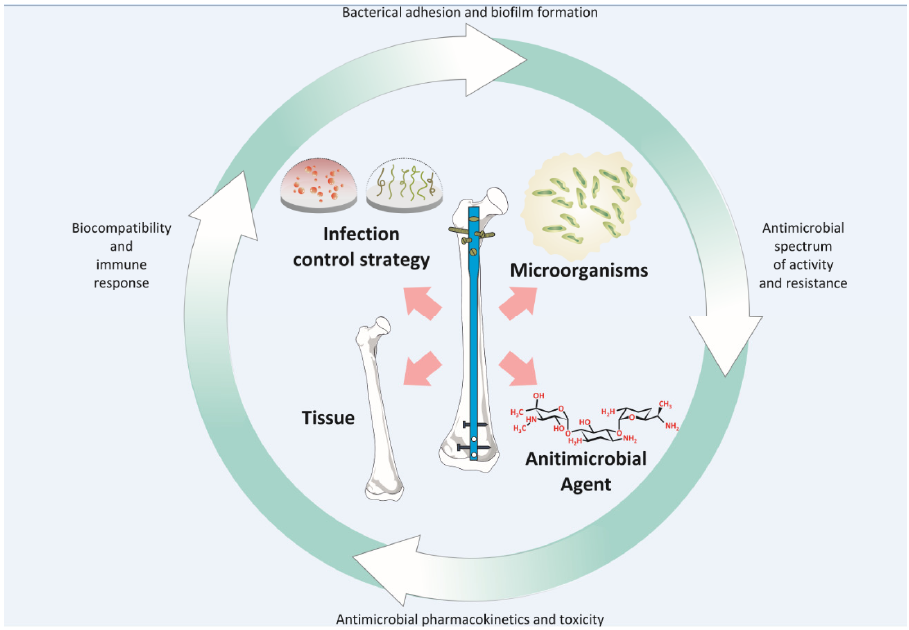
Figure 3. Important considerations impacting the design and clinical performance of orthopaedic devices incorporating antimicrobial agents to control device-related infection. devices incorporating antimicrobial agents to control device-related